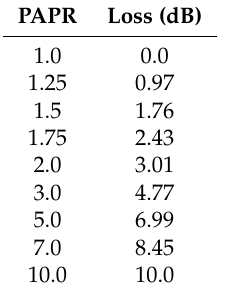
Table 1. Signal-to-noise ratio (SNR) loss (dB) versus peak-to-average power ratio